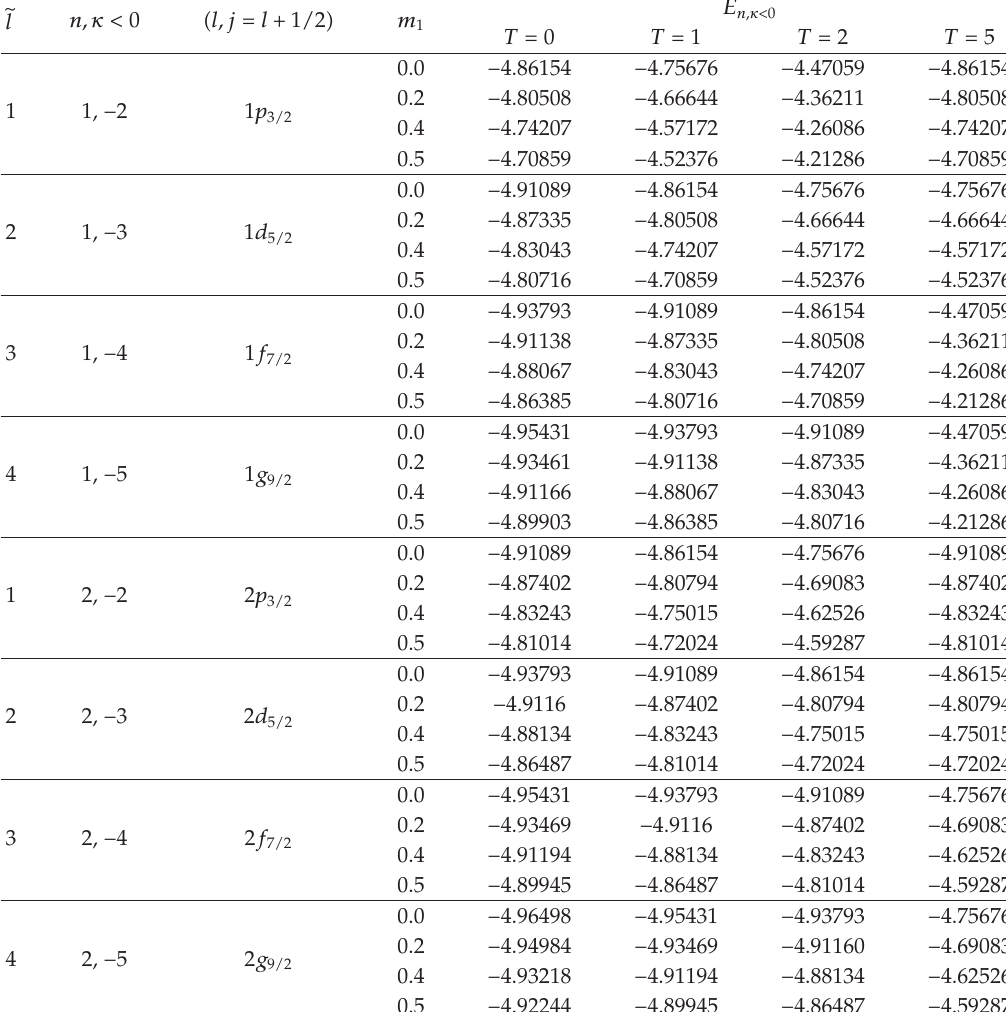
Table 1: The bound state energy eigenvalues of the Coulomb potential under the pseudo-spin symmetry limit for several values of n and κ for m 0 (cid:5) 5 . 0fm − 1 , (cid:2) (cid:5) c (cid:5) 1, q (cid:5) 1 , T (cid:5) (cid:2) 0 , 1 , 2 , 5 (cid:3) , and C ps (cid:5) −